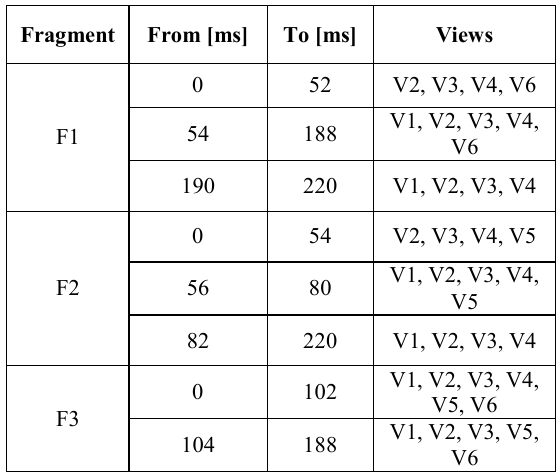
Table 5. Number of views used during processing as a function of different timeframes.